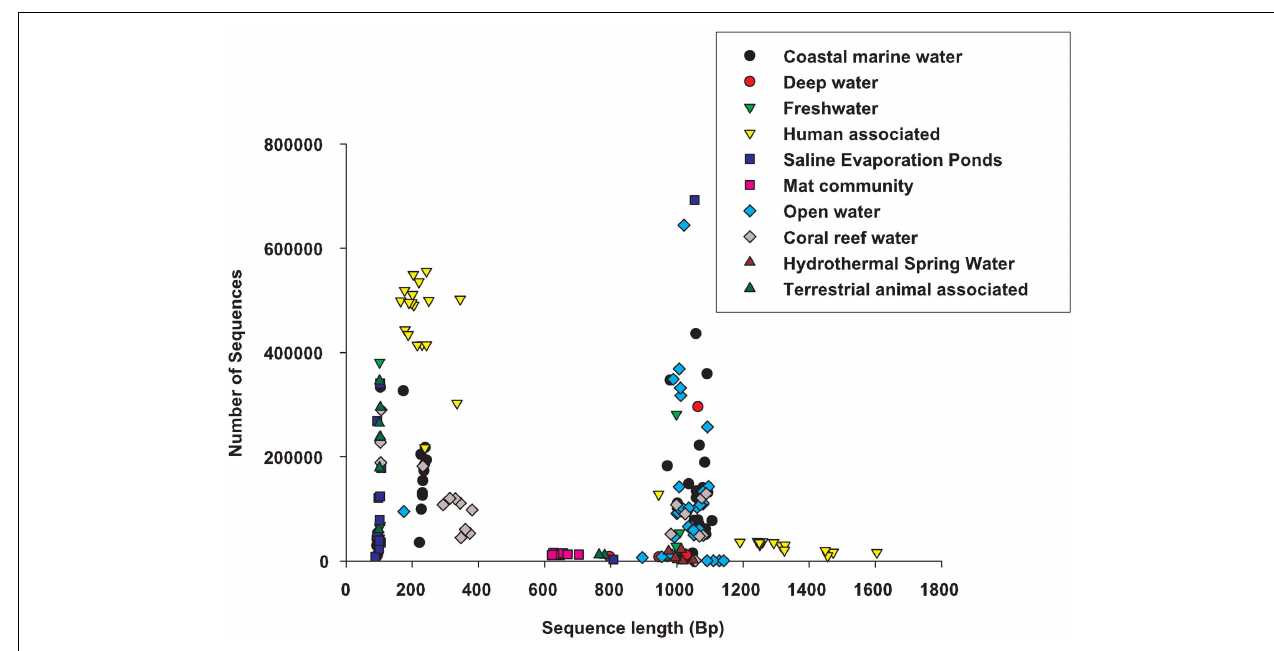
FIGURE 1 |A comparison of the sequence length and number of sequences across the environmental groups.